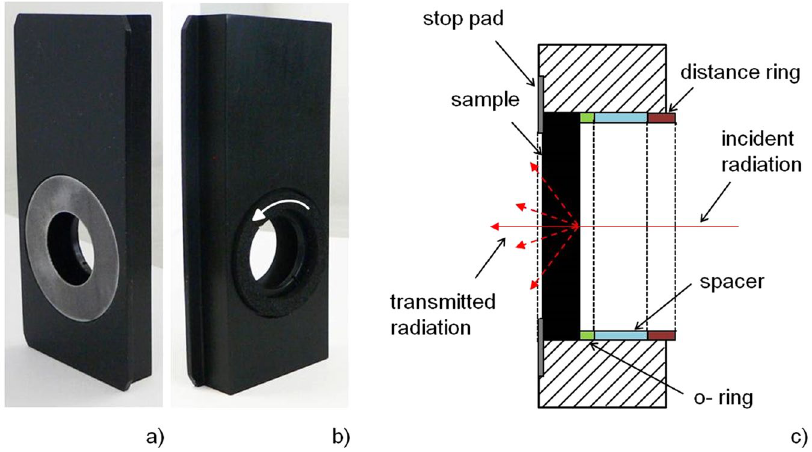
Figure 2. Transmittance accessory for bulk samples measurement. ( a ) Photograph of front view. ( b ) Photograph of back view. ( c ) Detail schematic view of sample